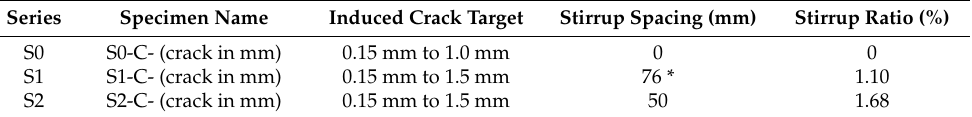
Figure 5. Specimen detail (example Series S2): ( a ) front view; ( b ) side view; and ( c ) upper view.